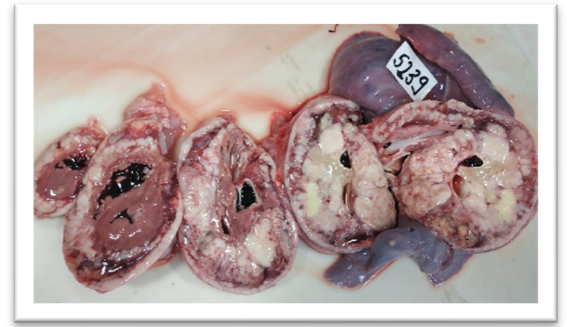
Figure 5. Malignant cardiac tumor developed in the heart with invasion of the entire pericardium.